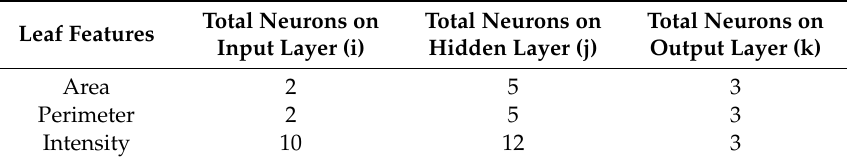
Table 3. Artificial neural network structure based on leaf features.